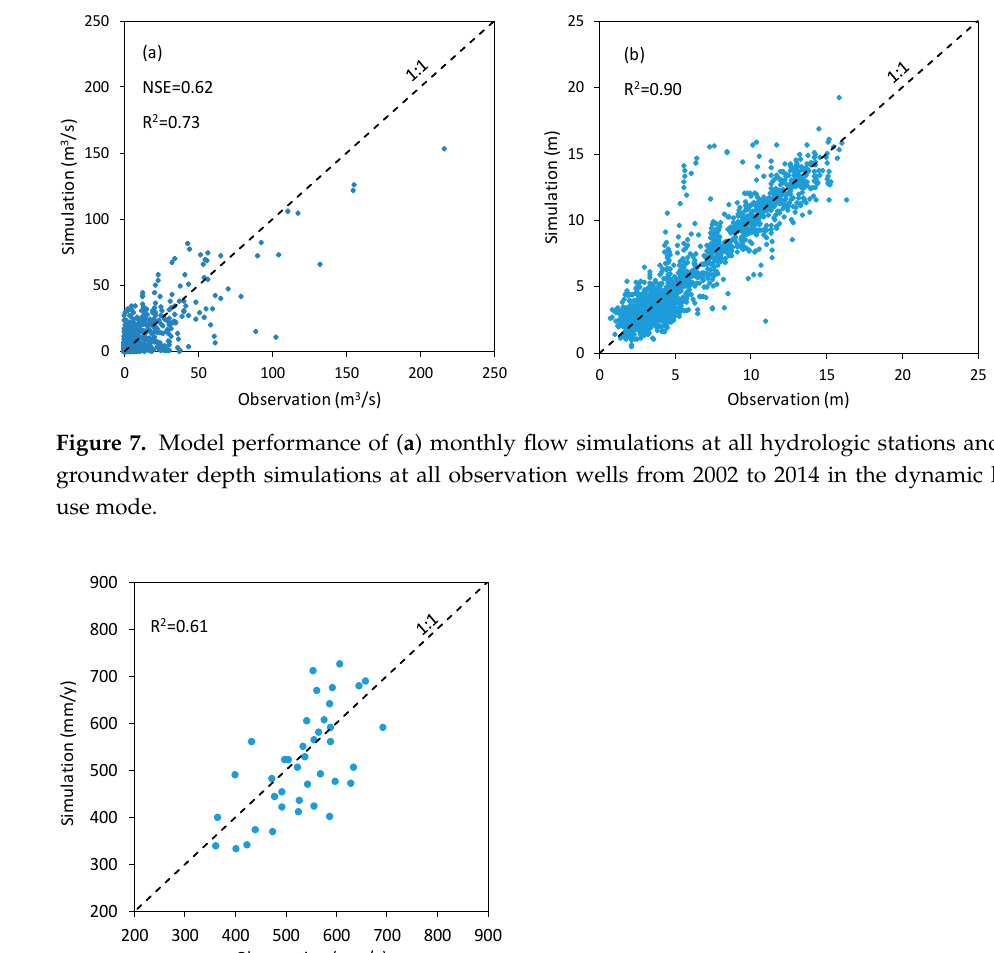
Figure 7. Model performance of ( a ) monthly flow simulations at all hydrologic stations and ( b ) groundwater depth simulations at all observation wells from 2002 to 2014 in the dynamic land use mode.